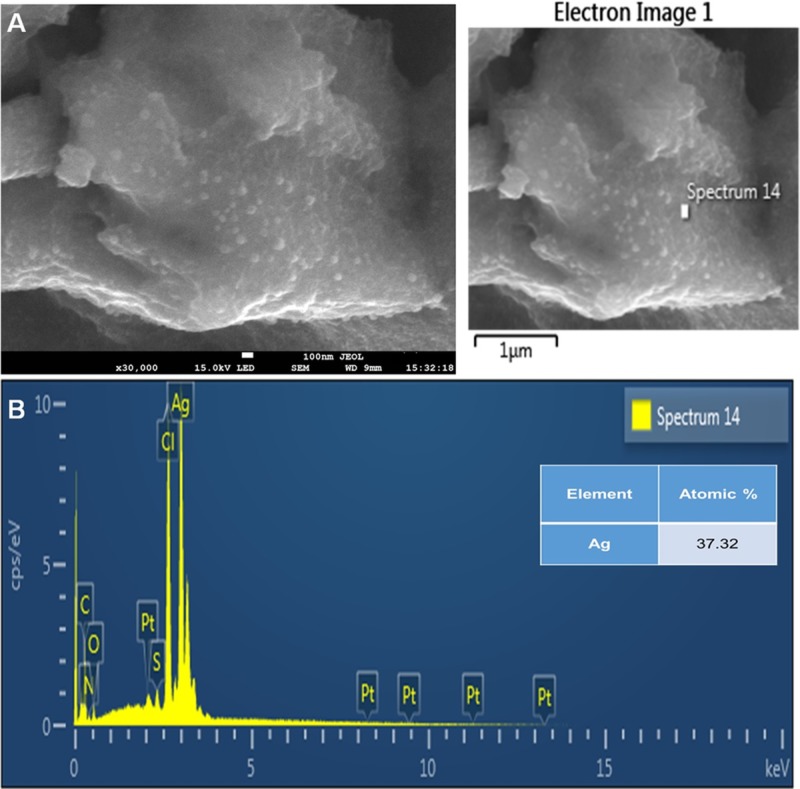
(A) SEM and (B) EDX spectral analysis of the biosynthesized AC-AgNPs.